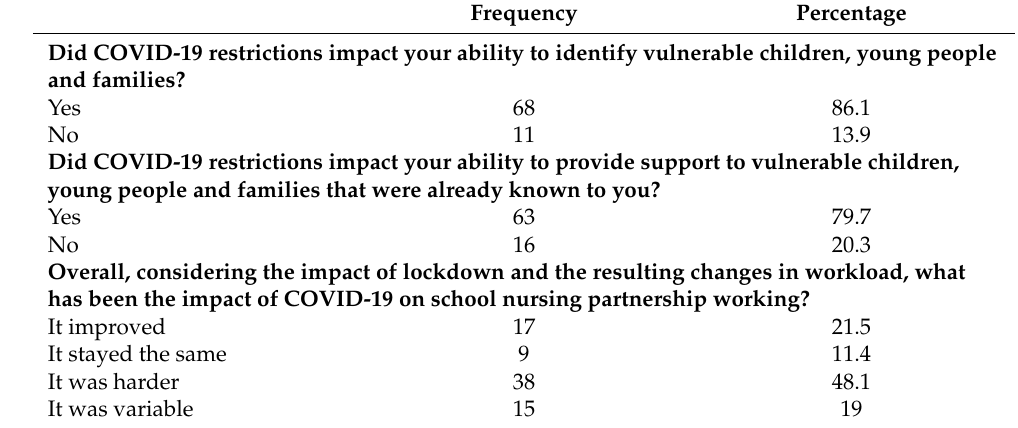
Table 4. The impact of COVID-19 and associated restrictions on school nurses’ ability to identify and work with vulnerable children, young people and families and the impact on partnership